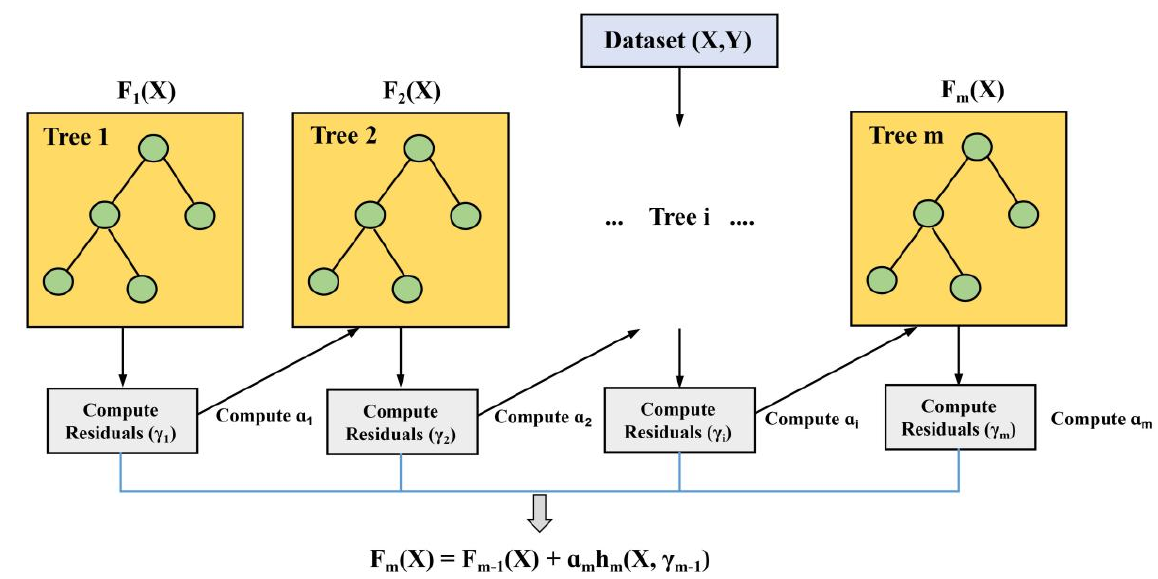
Figure 3. Brief illustration on how gradient tree boosting works. Note: α i and γ i are the regularization parameters and residual computed with the i th tree, respectively, and h i is a function that is trained to predict residuals, γ i using X for the i th tree. To obtain α i , we employed the residuals computed, γ i m ∑ = ) + α h ( X and computed the following: argmin L ( Y , F i − 1 ( X , γ i − 1 )) , where L(Y, F(X)) is a i i i i α i = 1 differentiable loss